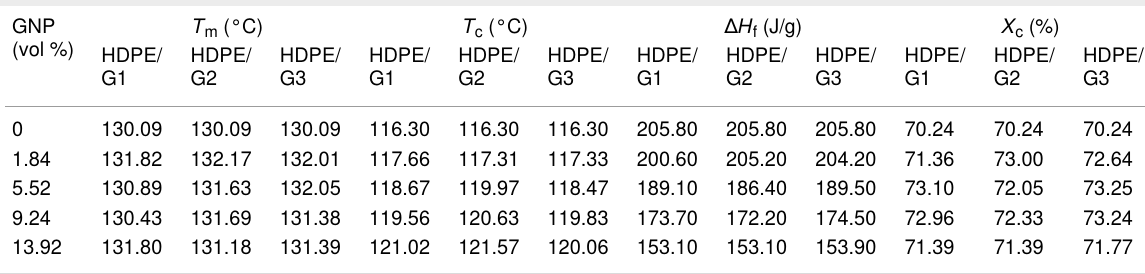
Table 2: DSC results for the HDPE/GnP nanocomposites. GNP (vol %)